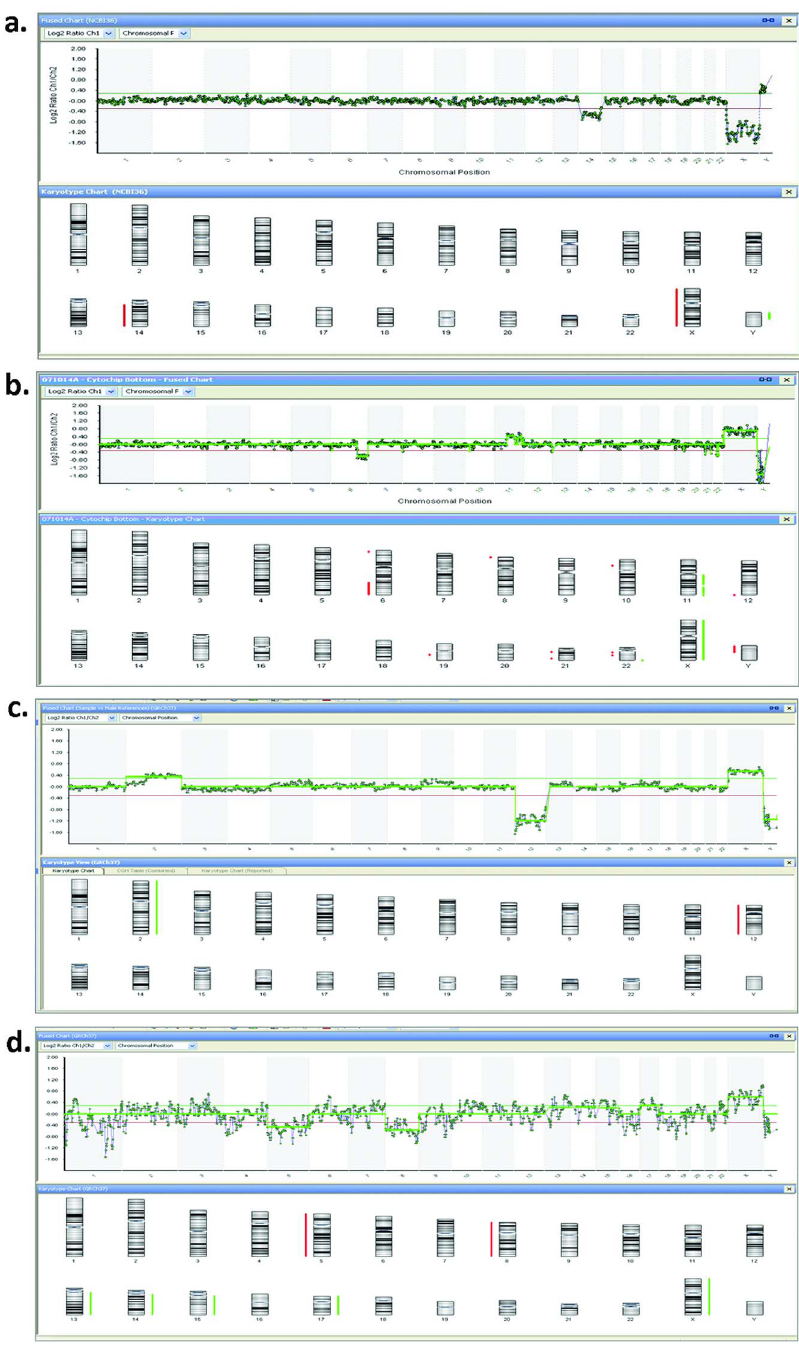
Figure 3. aCGH of abnormal single sperm.a . Molecular karyotype of a sperm with a loss of the entire chromosome 14 (arr 14p13q32.33(1– 106,864,802) 6 0) from a man with normozoospermia. b . Molecular karyotype of a sperm with a loss of part of chromosome 6 and a gain of part of chromosome 11 (arr 6q22.31q27(123,028,998–170,784,959) 6 0; arr 11q12.1q25(59,009,184–134,070,242) 6 2) from a man with normozoospermia. c . Molecular karyotype of an unbalanced sperm from a men with a balanced translocation t(2;12)(p11.2;q24.31): arr 2p11.2q37.3(86,951,334– 242,565,564) 6 2 and arr 12p13.33q24.33(1–133,851,895) 6 0. d . Complex molecular karyotype of a sperm from a patient after chemotherapy. doi:10.1371/journal.pone.0060922.g003 In the standard protocol of WGA (SurePlex WGA, BlueGnome, (Fig. 2a), and samples showing no smear or a weak smear Cambridge, UK) the analysis of the amplification products is underwent subsequent hybridization failure. We modified the performed by staining with SYBR safe DNA gel stain after WGA procedure to improve the sensitivity and the accuracy of the amplification. For this purpose the last PCR-based cycling step electrophoresis on 1% agarose gel. The smear intensity on the gel depends on the efficiency of the decondensation and/or of WGA was performed in Real-Time PCR with SYBR Green. Data